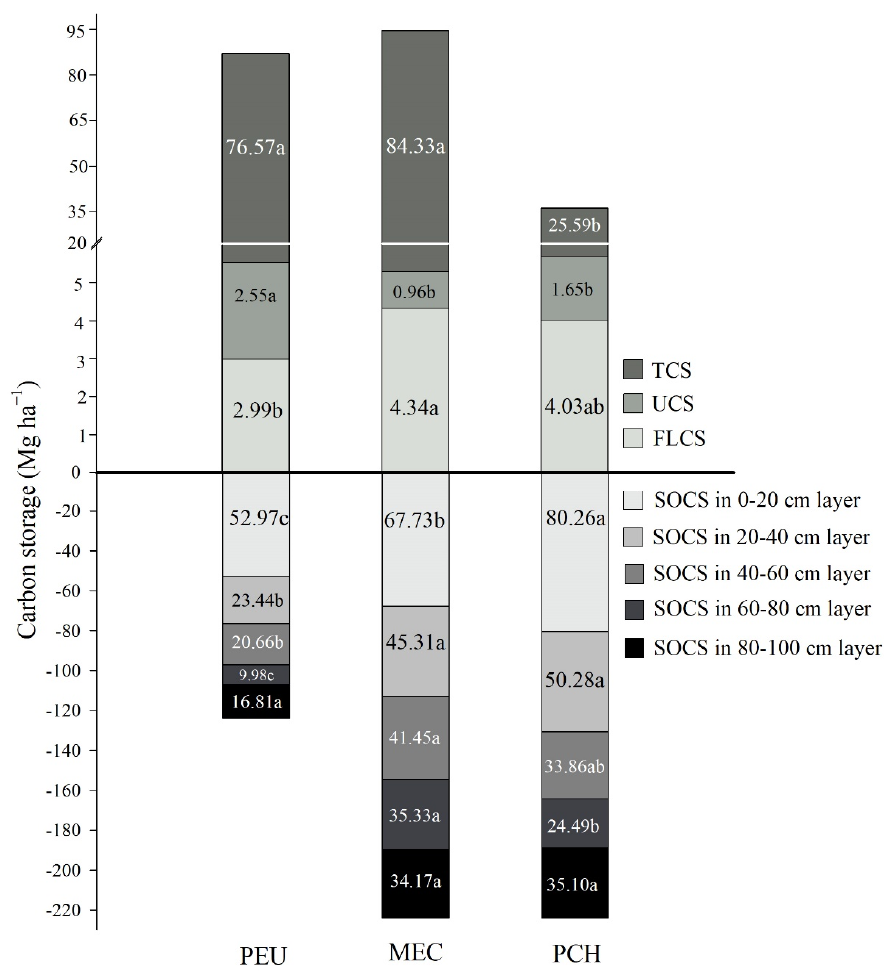
Figure 3. Amounts of carbon stored by trees, understory, litter (above the X -axis), and soil (below the X -axis) in the three plantation types. Numbers in the bars indicate the mean value ( n = 5). Different letters indicate significant differences (ANOVA, p < 0.05, least square difference analysis) among different plantations. TCS, tree carbon storage; UCS, understory carbon storage; FLCS, floor litter carbon storage; SOCS, soil organic carbon storage.